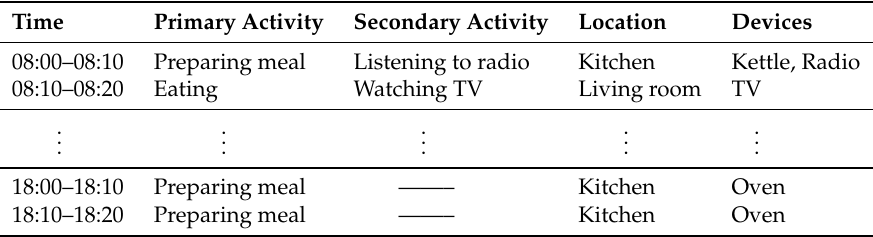
Table 4. Time use diary example.